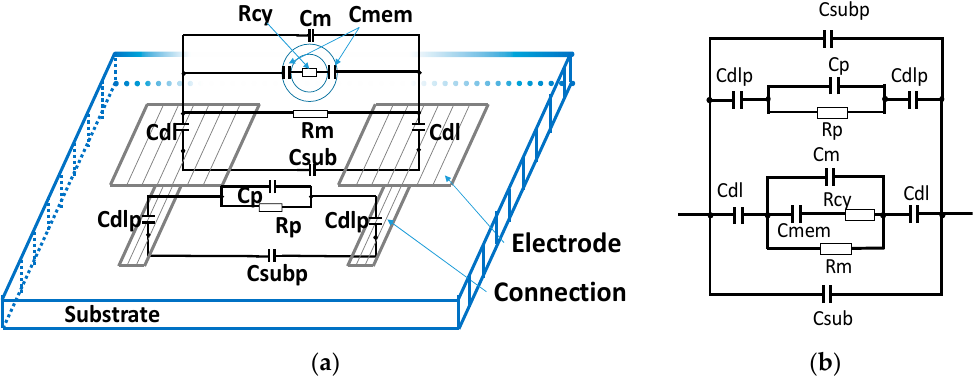
Figure 2. ( a ) Electrical components diagram for a pair of coplanar electrodes with a cell in the middle ( b ) and its electrical model.